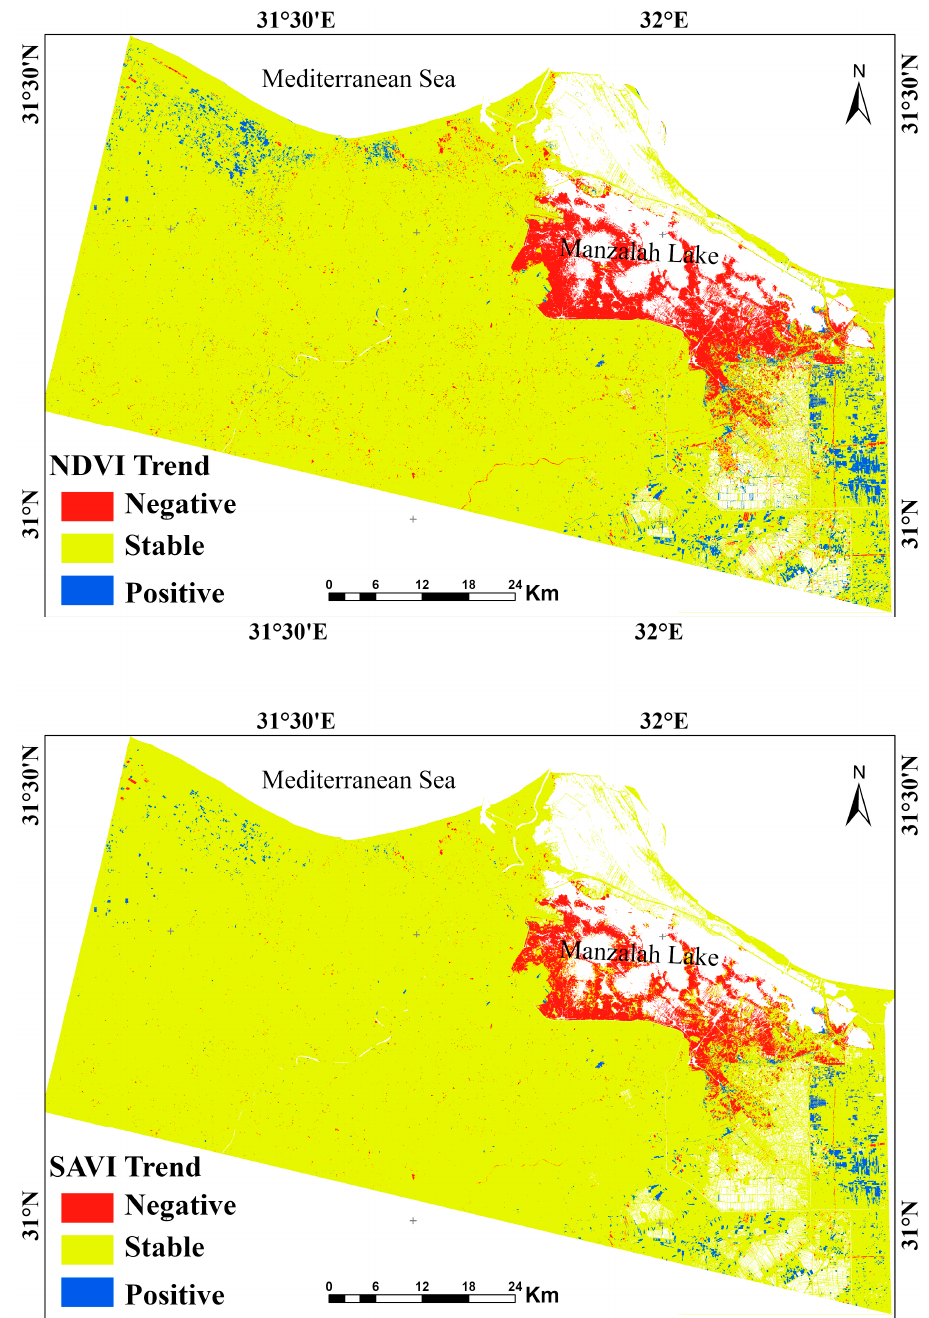
Figure 8. Trend analyses of Remote Sensing Indices (RSI) in the years from 2013 to 2023.